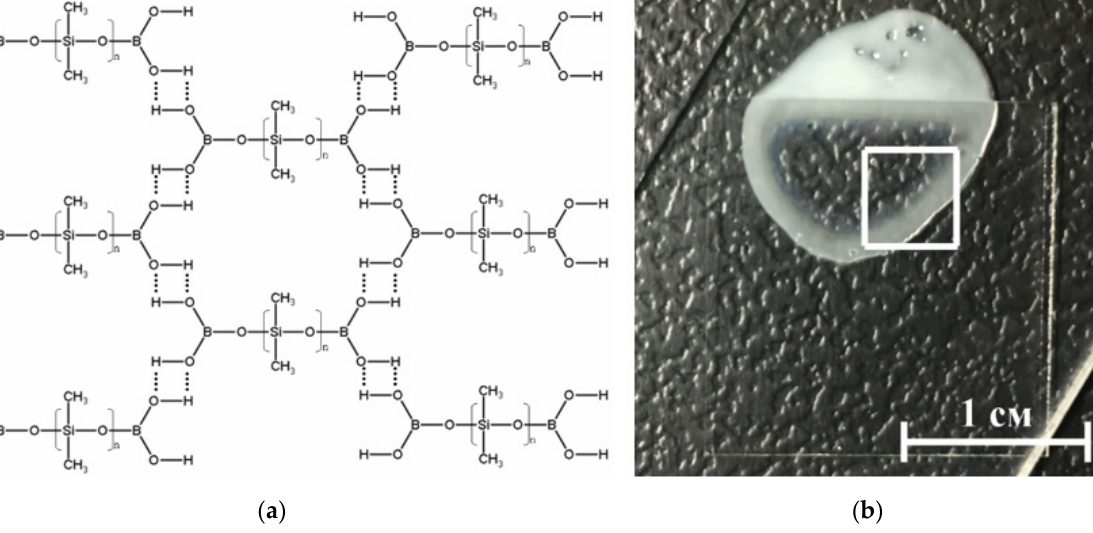
Figure 4. Influence of composite material based on boroxiloxane and zinc oxide nanoparticles on the mechanical spectra; storage modulus—blue symbol, loss modulus—red symbol. 3.2. Influence of Composite on ROS Generation and Damage to Biomolecules The metals of variable valence are capable to generate of reactive oxygen species (ROS). The effect of polymer and ZnO NPs on the generation of reactive oxygen species (hydrogen peroxide, as the most stable representative (Figure 5a) and hydroxyl radicals, as the most reactive (Figure 5b)) was studied. It was shown that borosiloxane has no effect on the generation of hydrogen peroxide. A composite material based on borosiloxane and ZnO nanoparticles doubles the rate of hydrogen peroxide generation at a nanoparticle mass concentration of 0.001%. The rate of generation of hydrogen peroxide increases in 5 times with an increase in the mass concentration of ZnO NPs. The borosiloxane has no effect on the generation of hydroxyl radicals. In this case, a composite material based on borosiloxane and zinc oxide